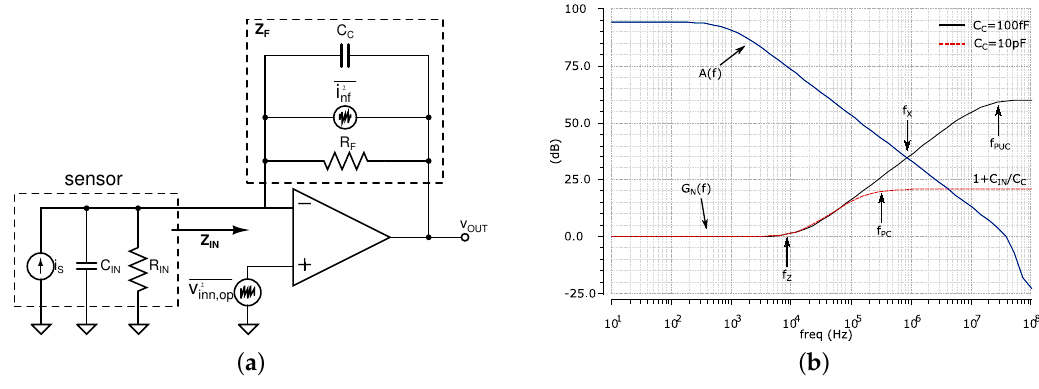
Figure 6. ( a ) Schematic of a TIA with the sensor model and noise sources; ( b ) simulated open-loop gain of the TIA op-amp and noise gain with different values of the compensation capacitor, C C